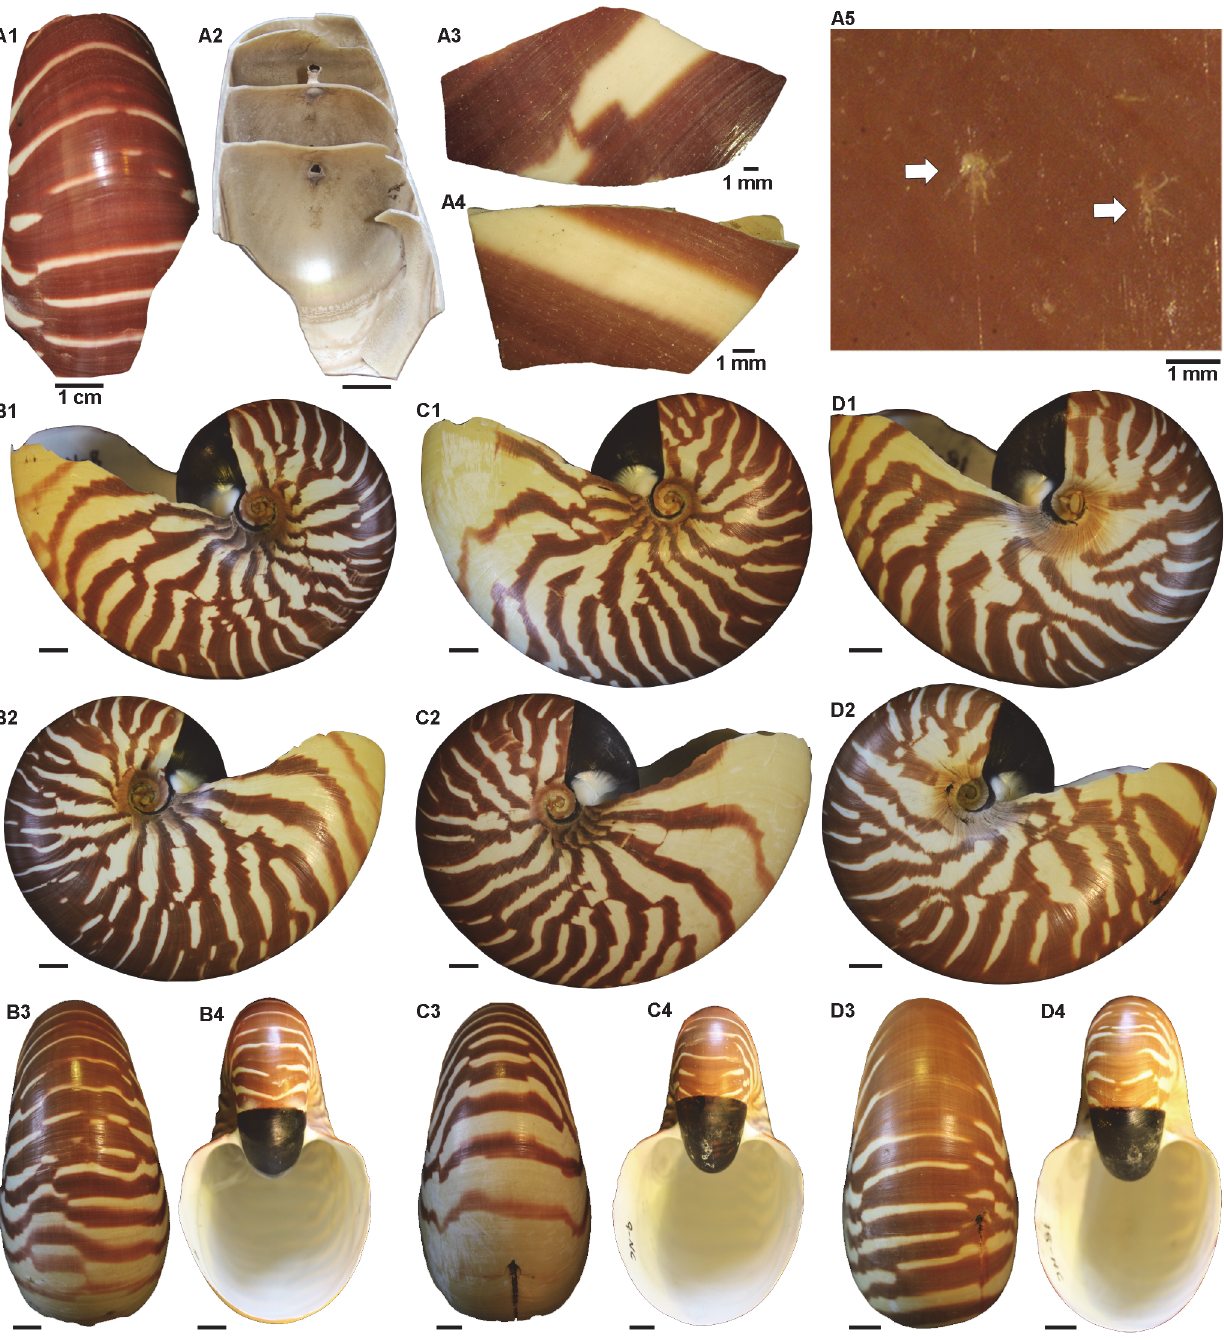
Fig 2. Shell fragments of the Nautilus pompilius specimen from Vanuatu (AMNH 310431) and the three Nautilus macromphalus specimens from New Caledonia. (A) N . pompilius . (A3-A4) Exemplary fragments of the shell. (A5) Dentritic structures on the shell surface produced by boring ‘ naked ’ foraminiferans (producing morphotype 3). (B) Specimen AMNH 93431, N . macromphalus . (C) Specimen AMNH 93432, N . macromphalus . (D) Specimen AMNH 93433, N . macromphalus . Scale bar for the shells is 1 cm unless indicated otherwise.